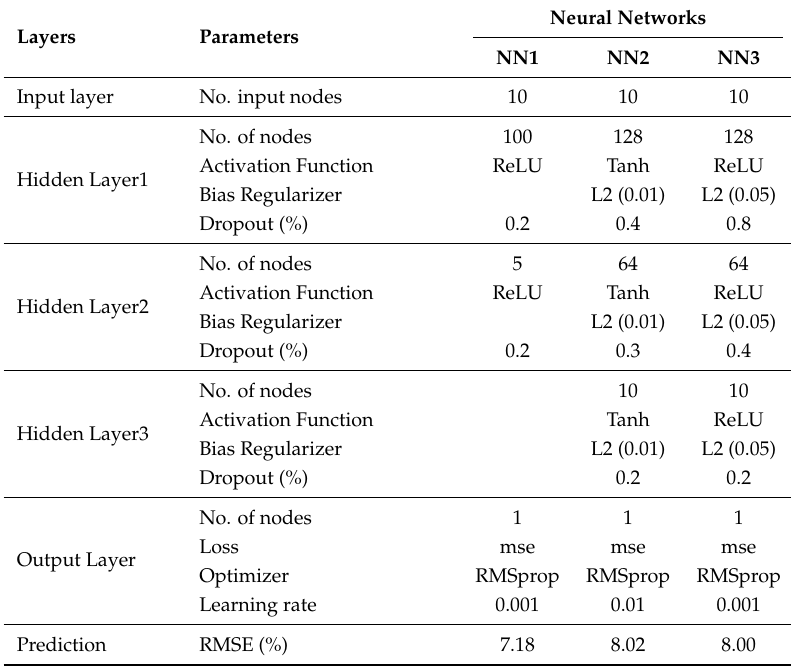
Table 6. Summary of parameters and statistics of the three Multi-Layer Perceptron (MLP) neural square optimization algorithm, ReLU: Rectified Linear Unit, Tanh: hyperbolic